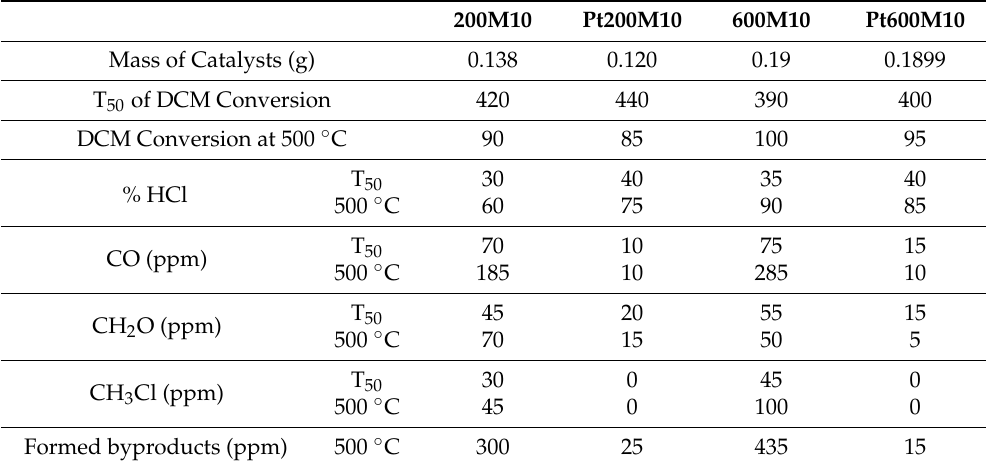
Figure 11. By-products formation ( a ) over 600M10 (Open symbols are used for Pt-containing 600M10 and closed are symbols for 600M10) and ( b ) comparison between 200M10 ( ● ) and 600M10 ( ■ ). The same experimental conditions were used as in Figure 6. Table 7. DCM conversion, HCl and byproduct yields over different catalysts zPtyM10, where z is 0 or 1 wt % of Pt and y is the density of monolith (200 and 600 cpsi).